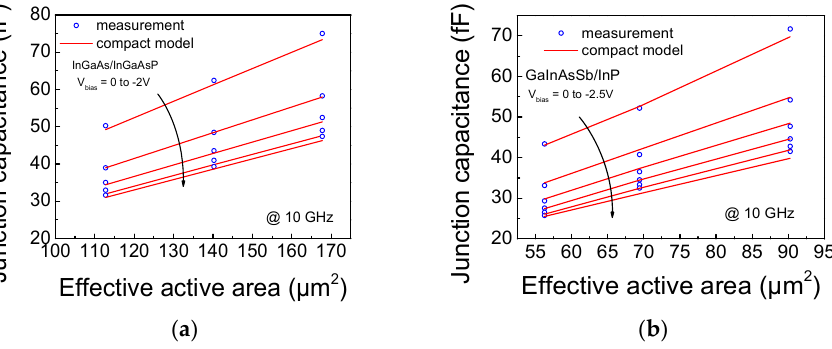
Figure 11. UTC-PD junction capacitance as functions of the active device area and the applied reverse bias: ( a ) InGaAs/InGaAsP UTC-PD ( b ) GaInAsSb/InP UTC-PD.